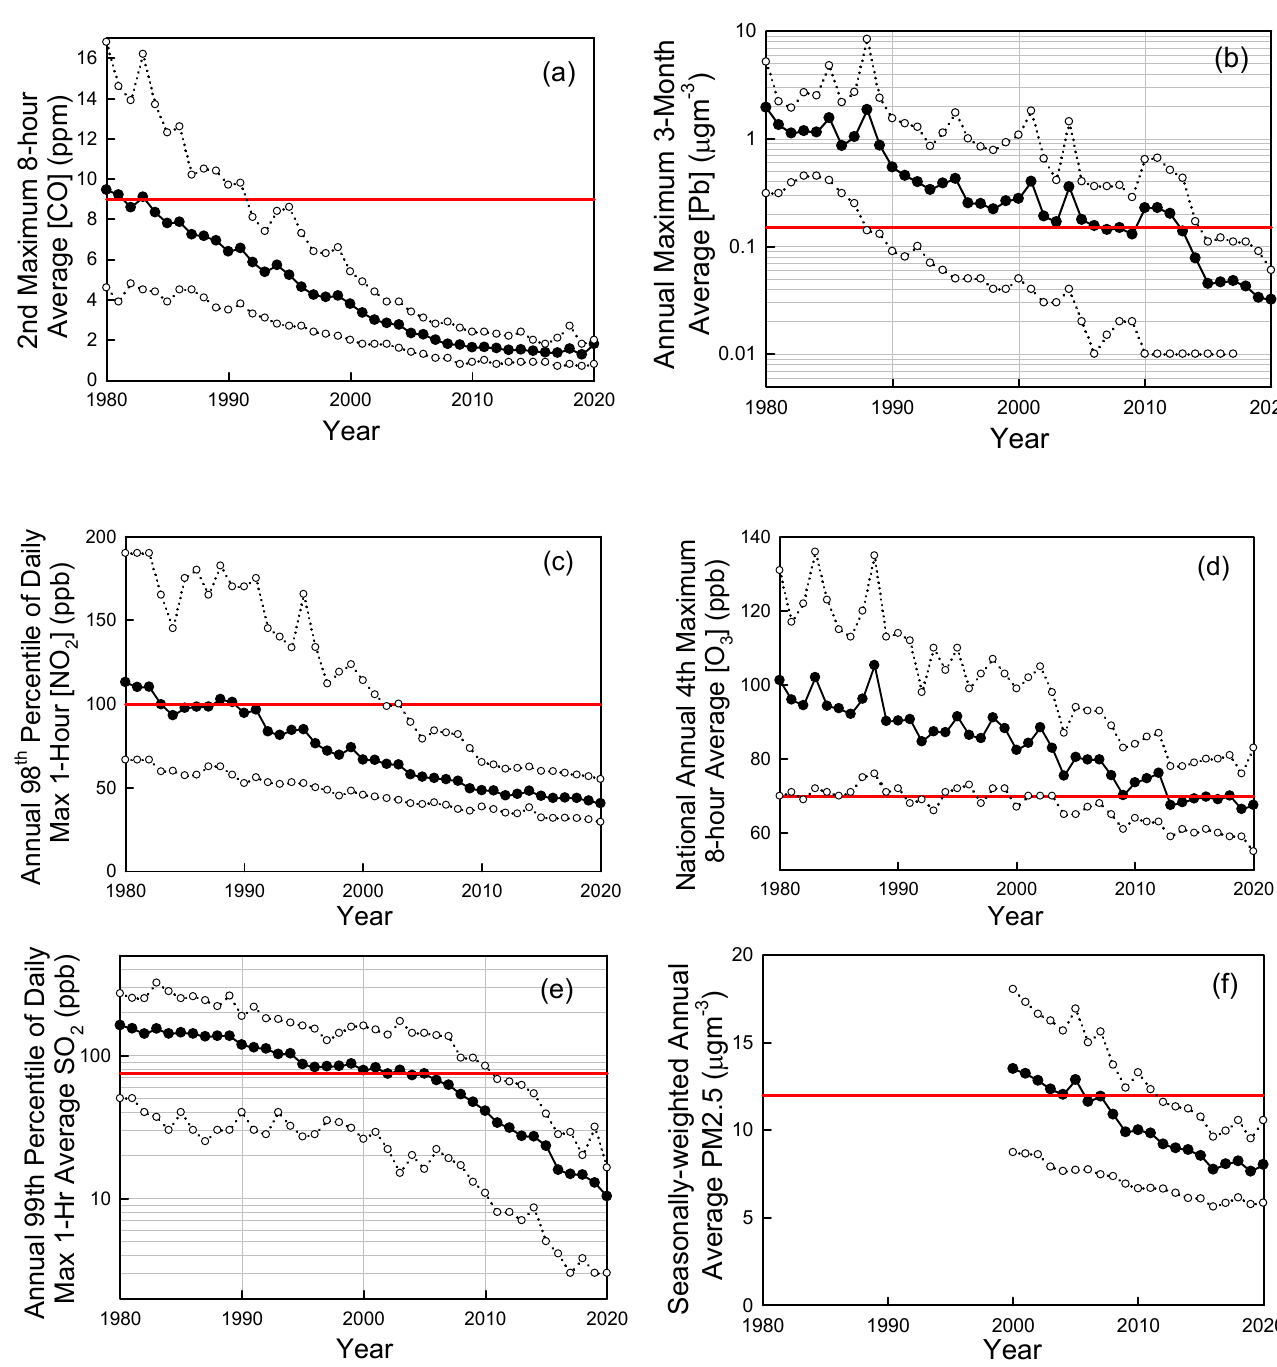
Figure 6. Trends in CO ( a ), lead (Pb) ( b ), NO 2 ( c ), ozone ( d ), SO 2 ( e ), and PM2.5 ( f ) in ambient urban air updated from Wallington et al. [45]. Solid symbols are averages, open symbols are 10th and 90th percentiles. The red horizontal lines are the primary National Ambient Air Quality Standards (NAAQS). Data were taken from the EPA Air Trends site [53] accessed in 2022 and 2019. PM2.5 levels have decreased to well below the 12 mg m − 3 NAAQS in most U.S. locations (see Figure 6f). However, recent epidemiological research suggests that there